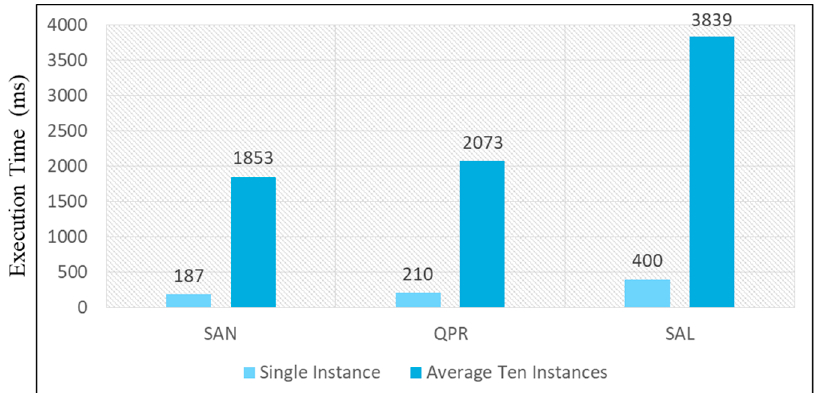
Figure 26. Microservices execution time analysis.